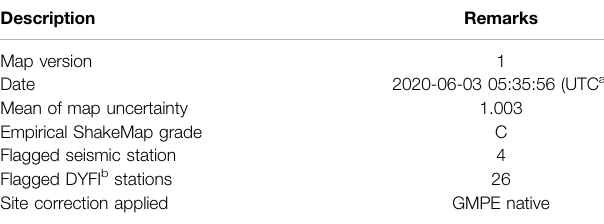
TABLE 3 | Metadata of USGS ShakeMap for the 2015 Gorkha